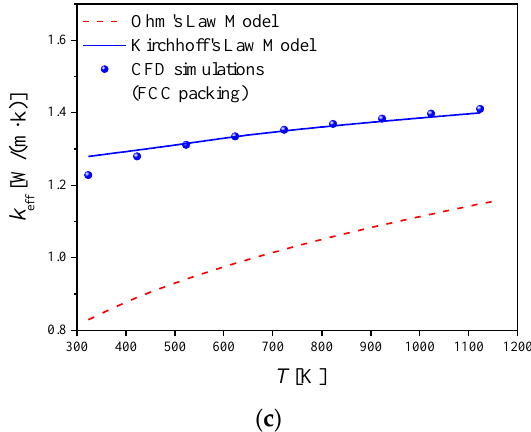
Figure 7. The effective thermal conductivities of ordered packings calculated with thermal resistance network method and computational fluid dynamics (CFD) simulations: ( a ) SC packing; ( b ) BCC packing; and ( c ) FCC packing.